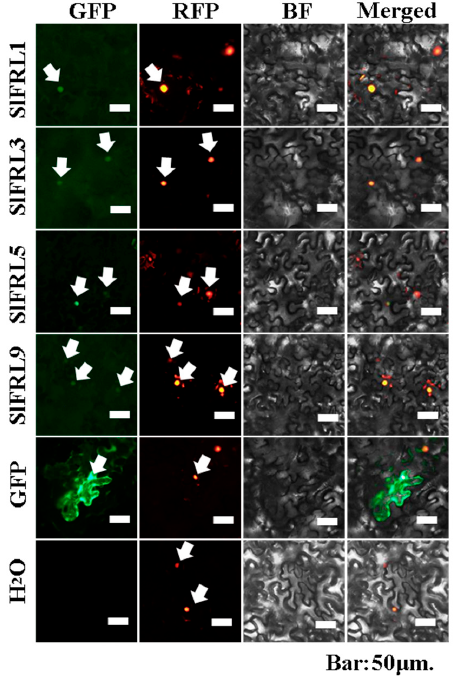
Figure 5. The subcellular localization of SIFRLs , bar = 50 μm . 2.5. The Expression Level Comparison of the Key Components of BR Pathway in Overexpression Lines of SlFRL5 and SlFRL9 Two basic components of BR synthesis are SlCPD and SlDWF. Increases in their level will reflect the decrease in BR signaling strength for the plant signaling feedback regula ‐ tion. Similarly, SlBIN2 is a core negative regulator of BR signaling, and increases in its level will inhibit BR signaling. The mRNA levels of SlCPD , SlDWF and SlBIN2 were de ‐ termined in SlFRL5 and SlFRL9 overexpression lines and wild type lines. The results in Figure 6 suggested that the mRNA level of SlBIN2 , SlCPD, and SlDWF in SlFRL5 and SlFRL9 overexpressed lines were significantly higher than that in wild type lines. These results indicated that SlFRL5 and SlFRL9 reduced BR signaling levels in tomatoes. 2.6. Overexpression of SlFRL5 and SlFRL9 Improved Plant Height and Early Flowering in Tomato After genetic transformation, three stable lines of SlFRLs T1 generation were selected and grown for 4 weeks. The results are presented in Figure 7, while A, C, E, and G are the phenotypes of SlFRL 1, 3, 5, and 9 overexpression lines. RT ‐ PCR was carried out to confirm the material. The plant heights of overexpressed lines of SlFRL 1, 3, 5, and 9 are shown in B, D, F, and H. According to the results, SlFRL5 ‐ and SlFRL9 ‐ overexpressed lines have increased plant height as compared to other SlFRLs, which are not significantly different.